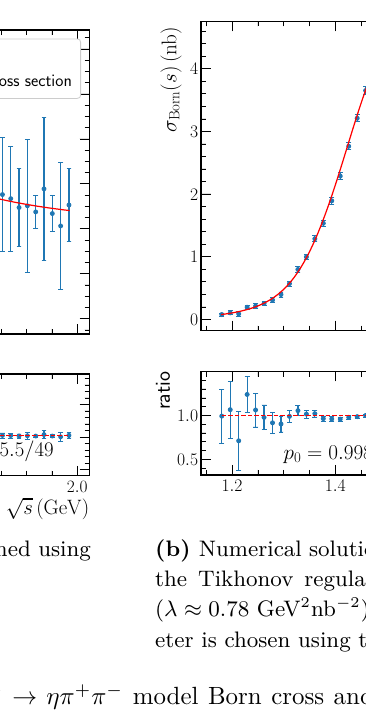
Figure 11. Comparison of the e + e − → ηπ + π − model Born cross and the numerical solution of eq. (1.5). Values of the parameter σ E at each c.m. energy point are same and equal to 20